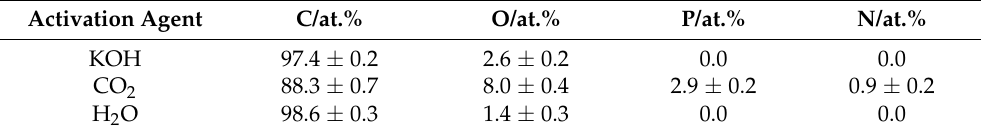
Table 2. Chemical composition of the fabricated electrodes from the ACFs. The values are calculated from at least 20 EDX spectra per sample and are arithmetic mean values with the corresponding confidence interval at a significance level of 0.05. C/at.% O/at.% P/at.% N/at.%